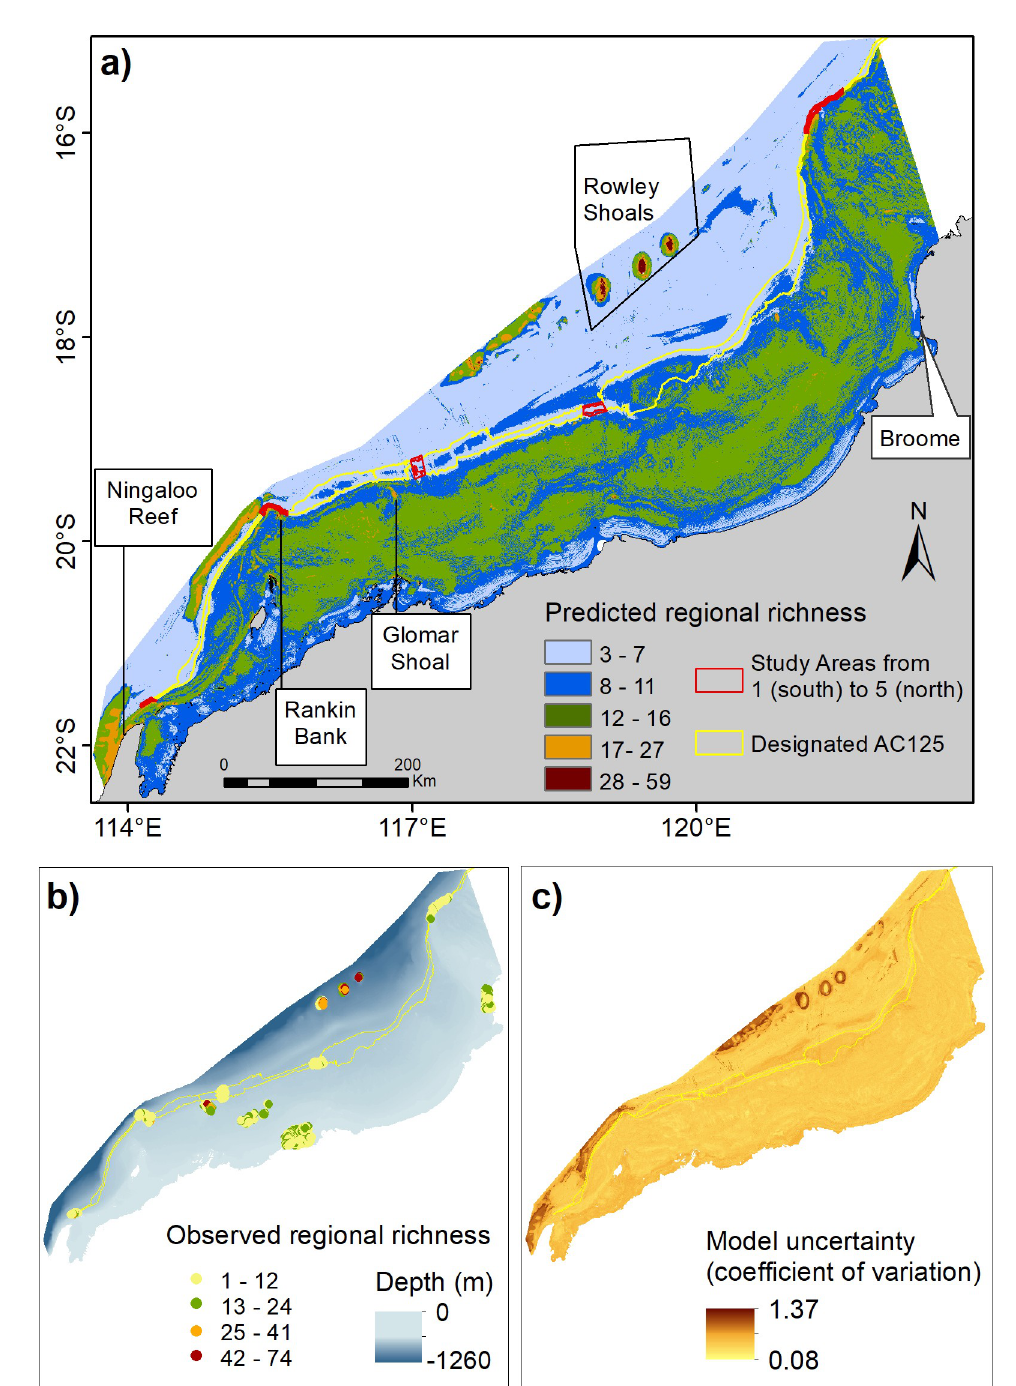
Fig 10. Predicted regional fish species richness for the North West Shelf (a) with locations of BRUVS deployments used in model fitting procedures plotted (b, bubble colours indicate the observed species richness) and associated uncertainty surface of the fitted RF model (c). This map was generated using ESRI software.